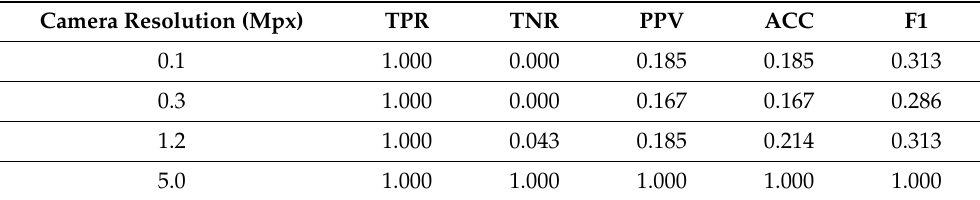
Figure 11. F1 score obtained for the bee identification process for different camera resolutions. Table 4. Effectiveness of V. destructor detection depending on camera resolution (TPR—sensitivity, TNR—specificity, PPV—precision, ACC—accuracy, F1